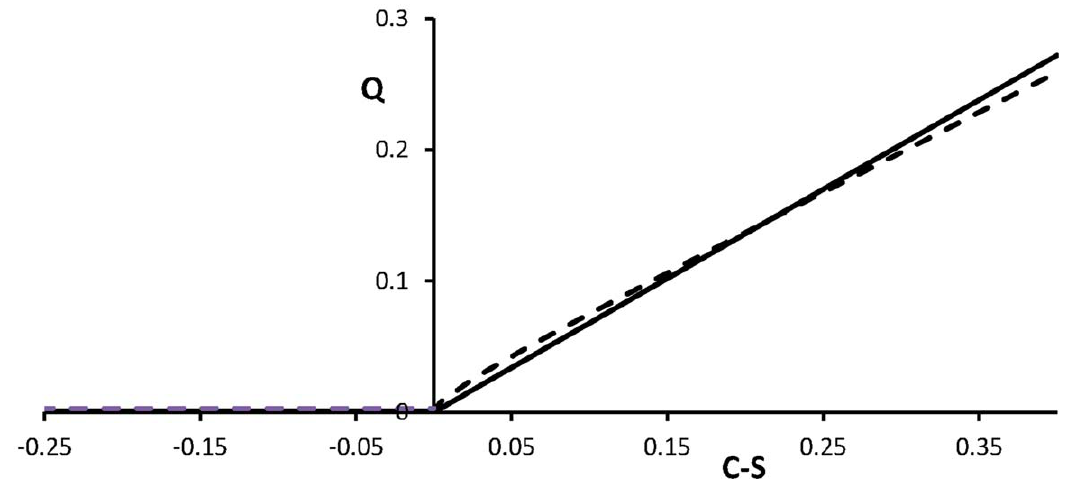
Figure 1. Nicotine intake Q as a function of the craving C and control S . Assuming a fixed urge to light a cigarette (solid) with l =0.68 ( C – S ) and the case of an urge increasing linearly in time (dashed) with l ( t )=(0.6 + 0.013 t ) ( C – S ).